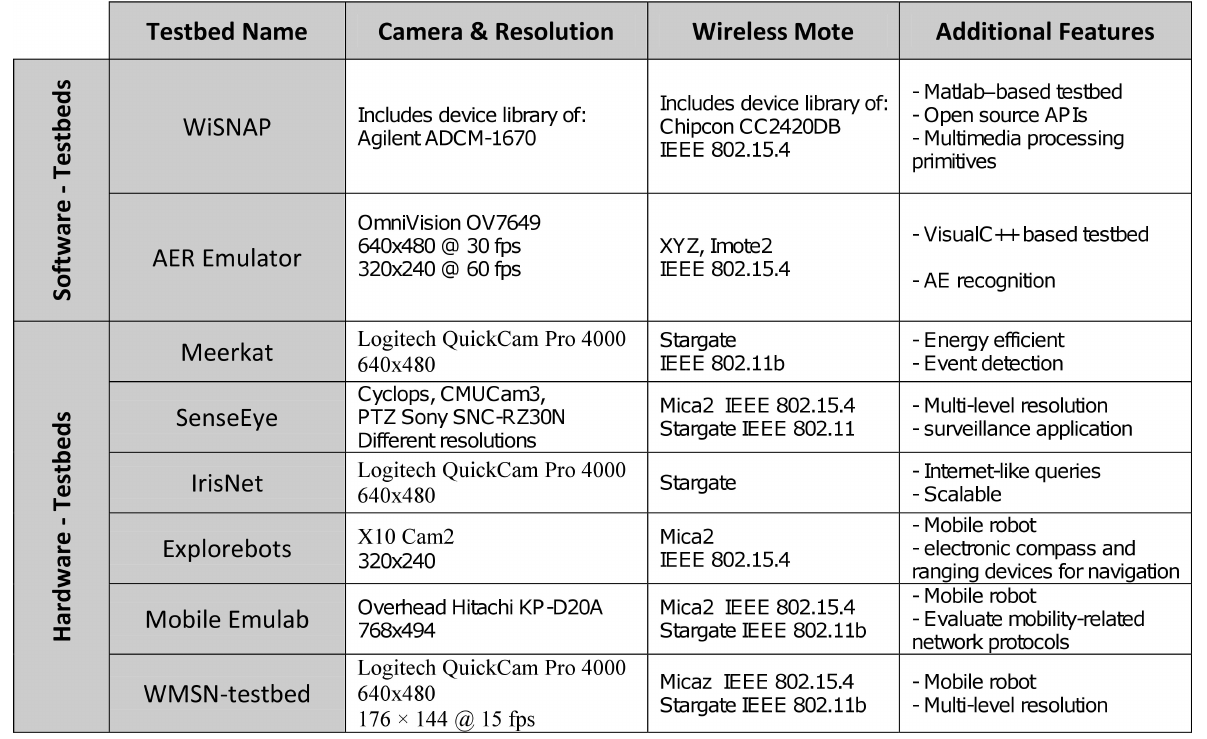
Table 6. WMSN Testbeds